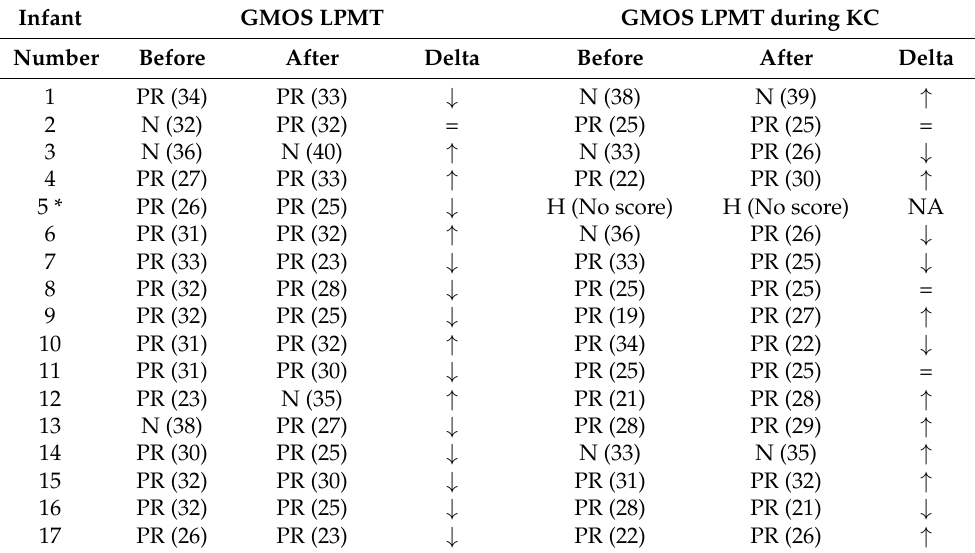
PR (32) PR (25) ↓ ↓ ↓ PR (26)